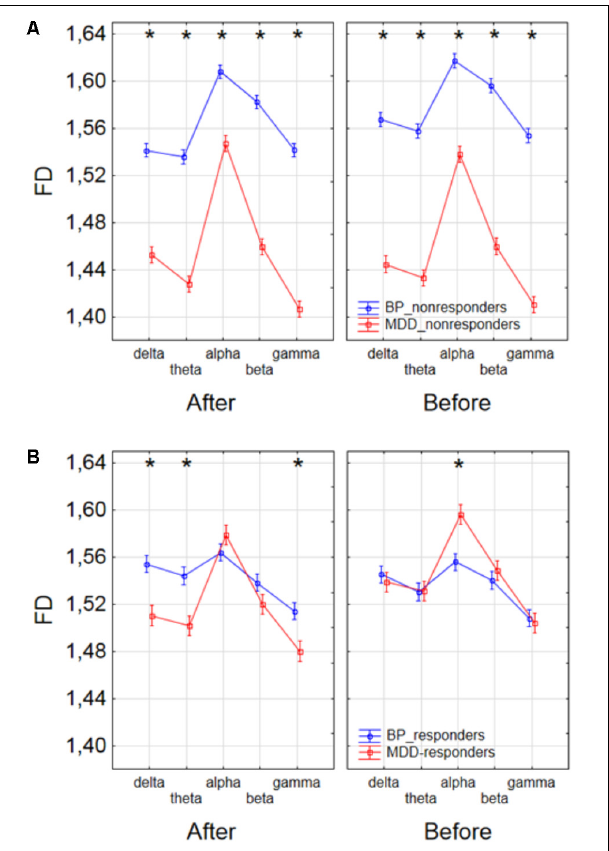
FIGURE 7 | Comparison of FD value between BP_non-responders and MDD_non-responders groups (A) and between BP_responders and MDD_responders groups (B) in each frequency band separately, for condition before and after session. The interaction between factors CONDITION, BAND and GROUP (comparison between groups of MDD and BP patients separately for responders and non-responders). Significant differences between both groups for the individual frequency bands and conditions, evaluated by post hoc Tukey HSD test, were marked with asterisks.